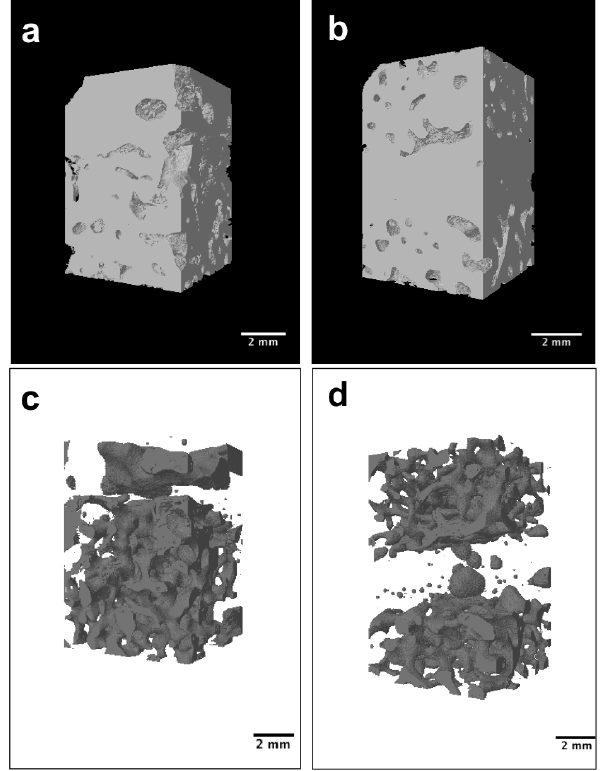
Figure 4. Reconstructed three-dimensional images of sub-samples of the ice phase of (a) ice layer 1 and (b) ice layer 2, and the pore phase of (c) ice layer 1 and (d) ice layer